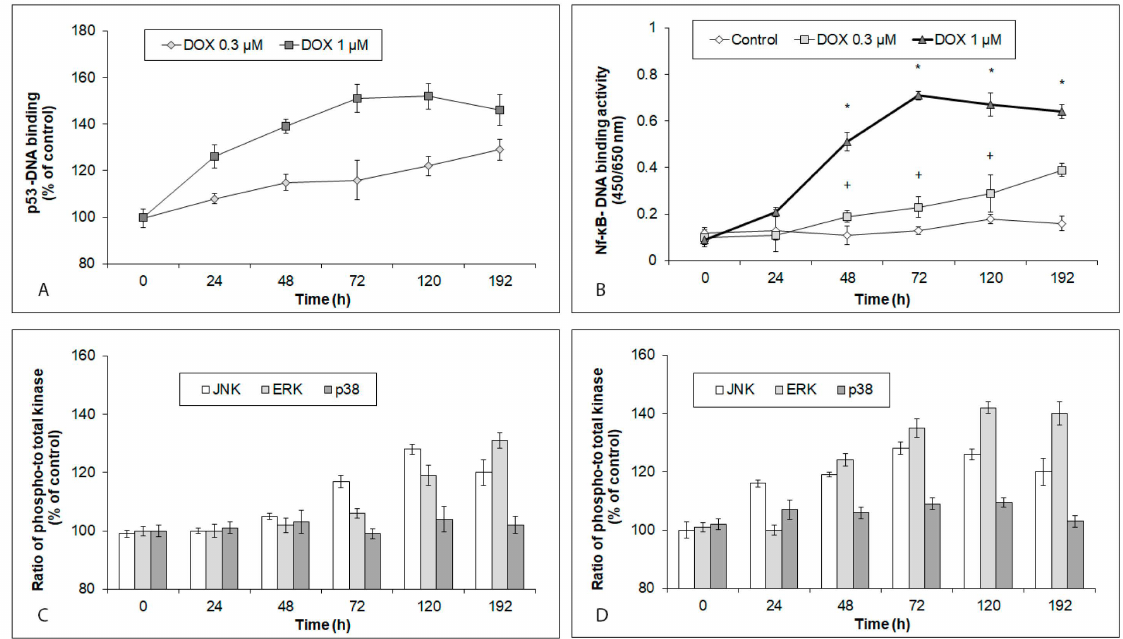
Figure 3. Effects of 0.3 µ M and 1 µ M DOX on intracellular signaling in hiPCS-CMs during 192 h. Control and DOX-exposed cardiomyocytes were harvested at individual time intervals, and ( A ) p53 activity, ( B ) NF- κ B activity, ( C ) MAP kinases activity upon treatment with 0.3 µ M DOX, and ( D ) MAP kinases activity upon treatment with 1 µ M DOX, were determined by particular assays and procedures, as described in Section 4. Values represent means ± SD of N = 3 (p53 activity), N = 3 (NF- κ B activity), N = 3 (MAP kinases activity at 0.3 µ M DOX), and N = 3 (MAP kinases activity at 1 µ M DOX) experiments. * p < 0.05 compared to untreated control cells at the same treatment